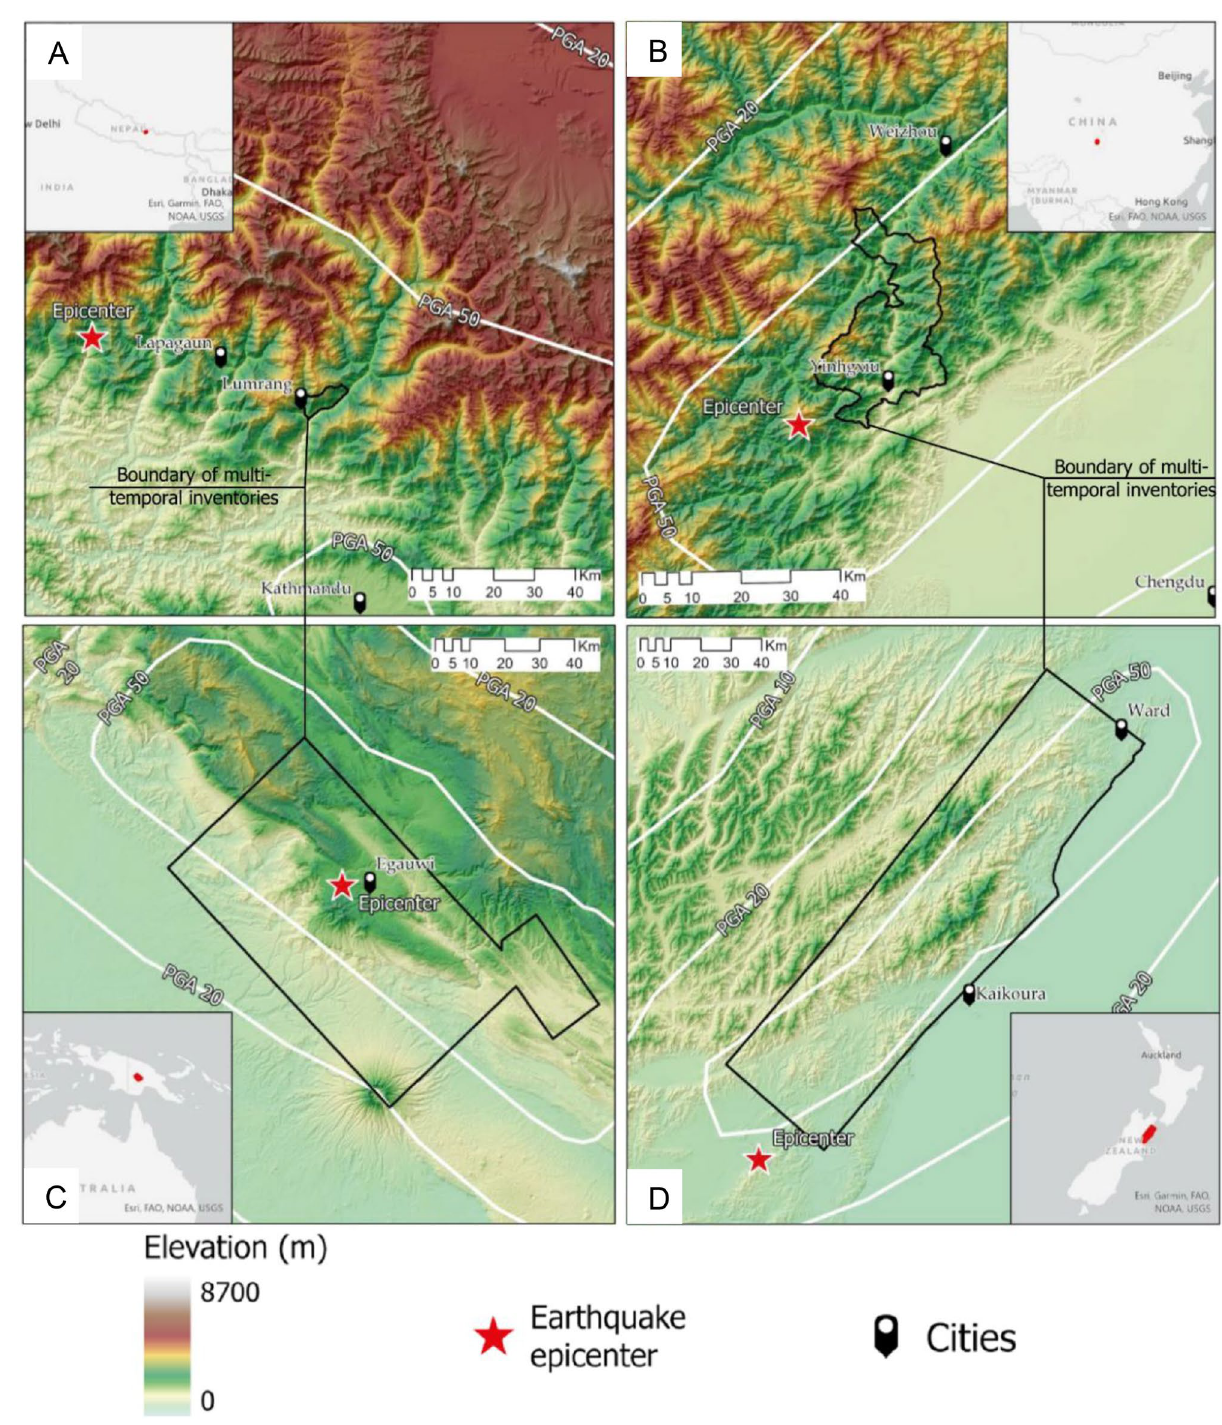
Figure 2. Study areas with the respective epicentres of the triggering events, the important cities within the vicinity of the investigation areas, and the PGA values (in